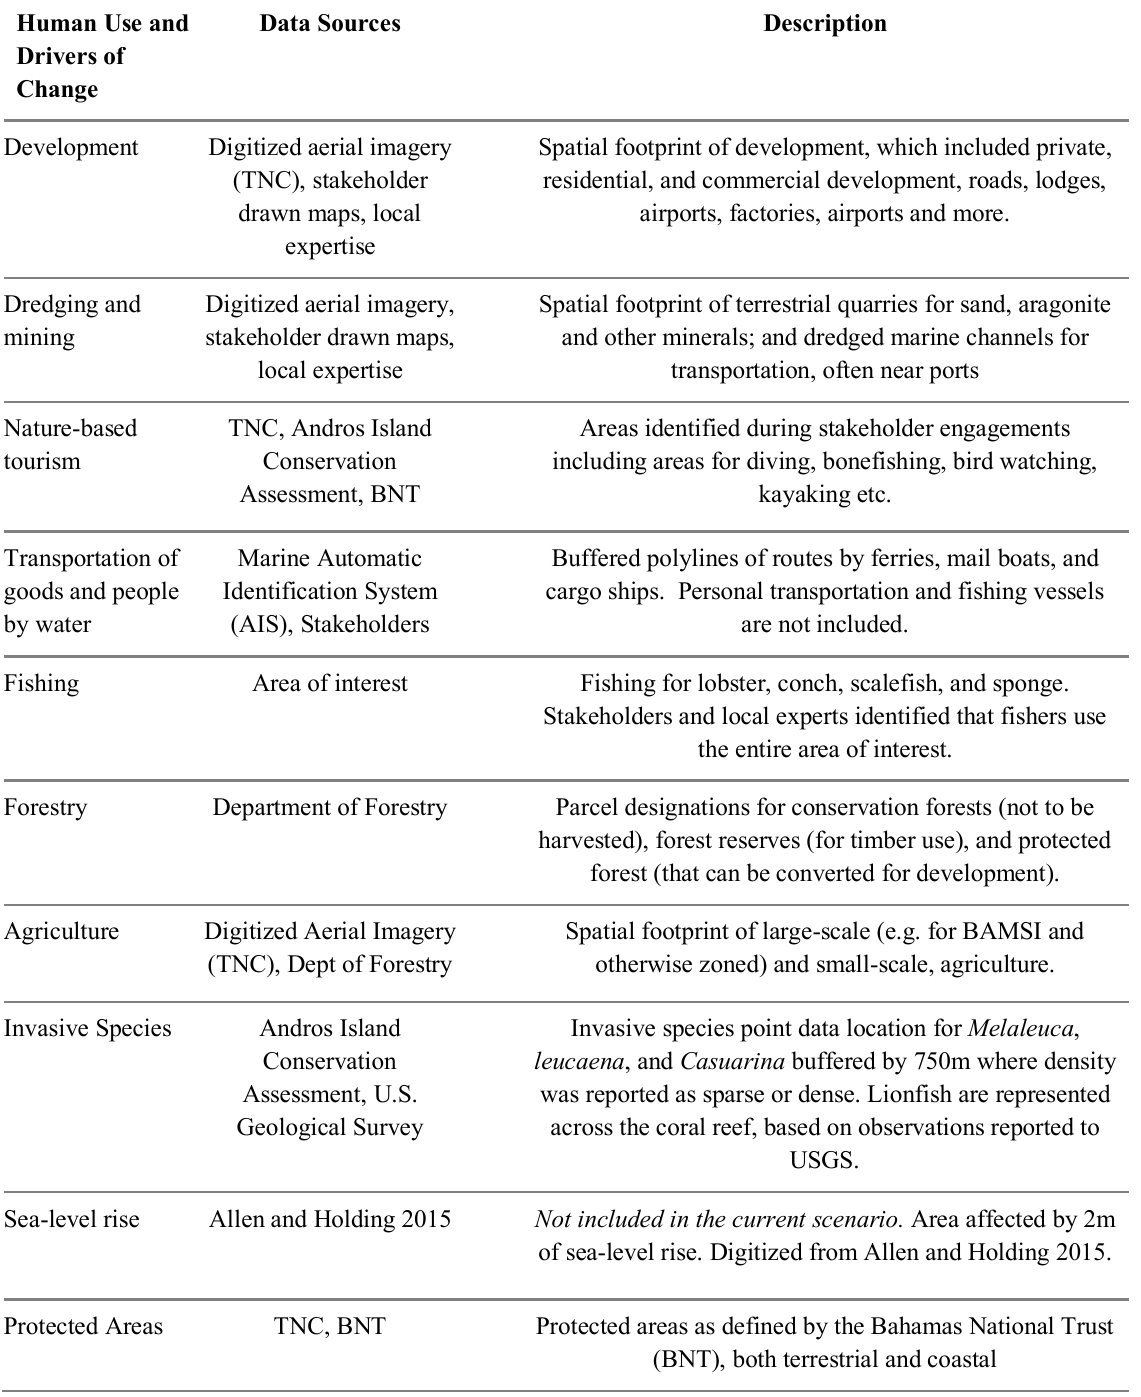
Table A1.3 Data originate from multiple sources, including from partners at The Nature Conservancy (TNC) and Bahamas National Trust